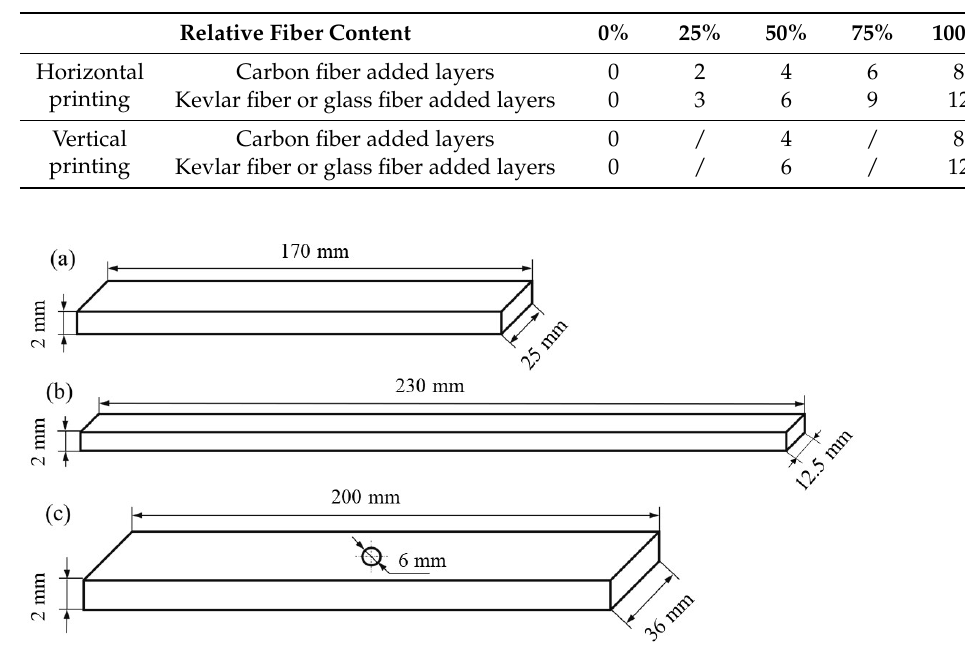
Figure 2. ( a ) The dimensions of the un-notched sample with 90 ◦ fiber arrangement, ( b ) the dimensions of the un-notched sample with 0 ◦ fiber arrangement, ( c ) the dimensions of the sample with a central notch.